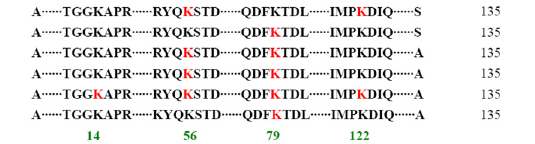
Fig 4. Comparison of the succinylated residues in histone H3 of S . lycopersicum with that of five other species. Red sequences indicate succinylation sites. Numbers below the sequences represent the amino acid